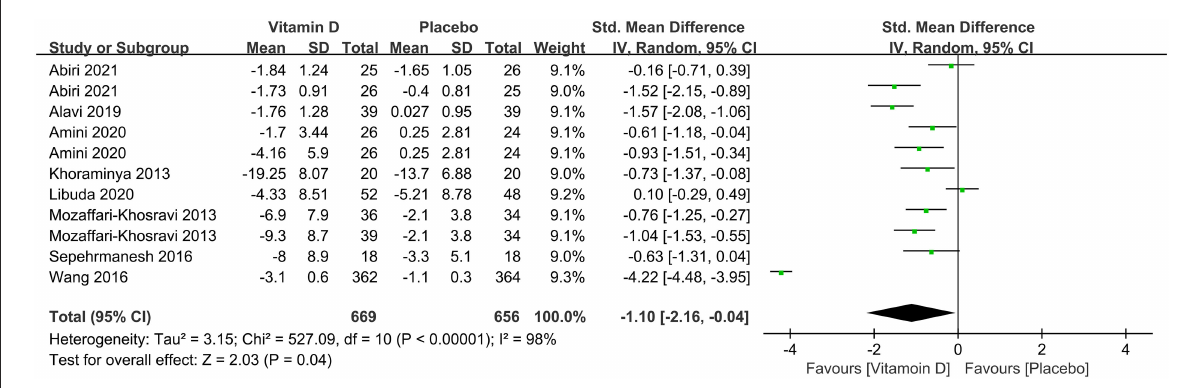
FIGURE6 Forest plot of the correlation between vitamin D and the prognosis of depression for patients with low vitamin D levels ( < 50 nmol/L).